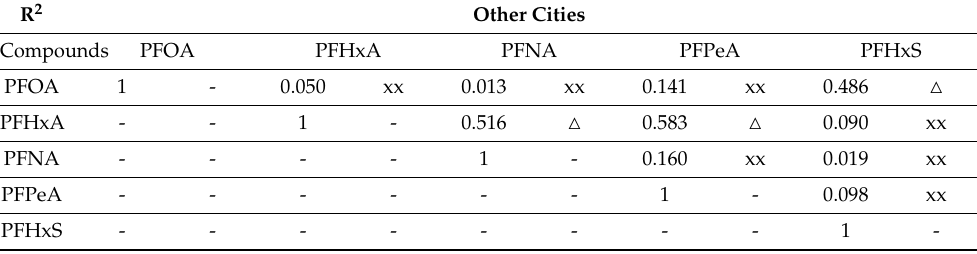
Table 2. Comparison of correlation coe ffi cients of PFCs with other cities with similar populations and industries (xx: 0-0.2; x: 0.21-0.4; (cid:52) : 0.41-0.6; PFOA: perfluorooctanoic acid; PFPeA: perfluoro-n-pentanoic acid; PFHxS: perfluorohexane sulfonate; PFHxA: perfluorohexanoic acid;